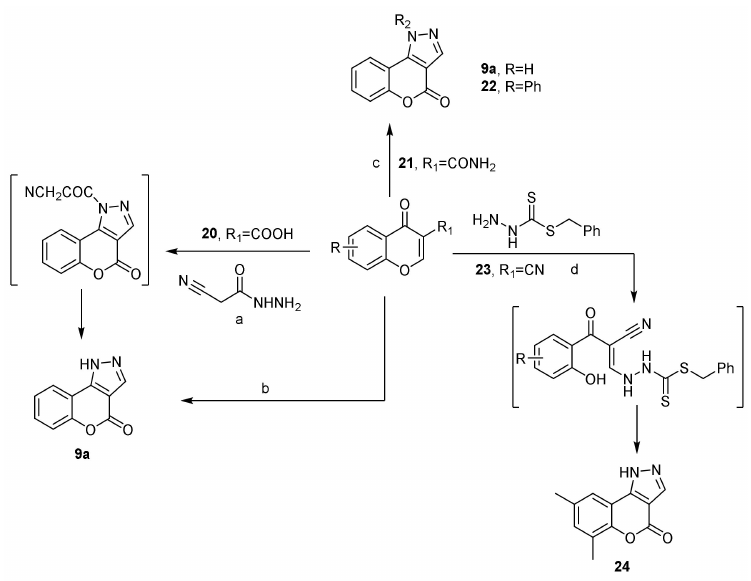
Scheme 7. Synthesis of chromeno[4,3- c ]pyrazol-4(2 H )-ones 9a , 22 , and 24 . Reagents and